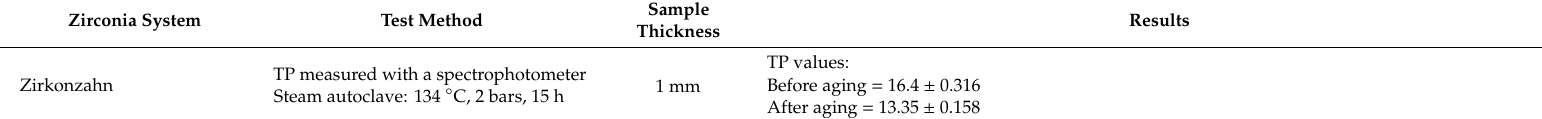
Table 1. Studies investigating optical properties of monolithic zirconia specimens / crowns after aging. Studies are presented in ascending chronological order. Authors